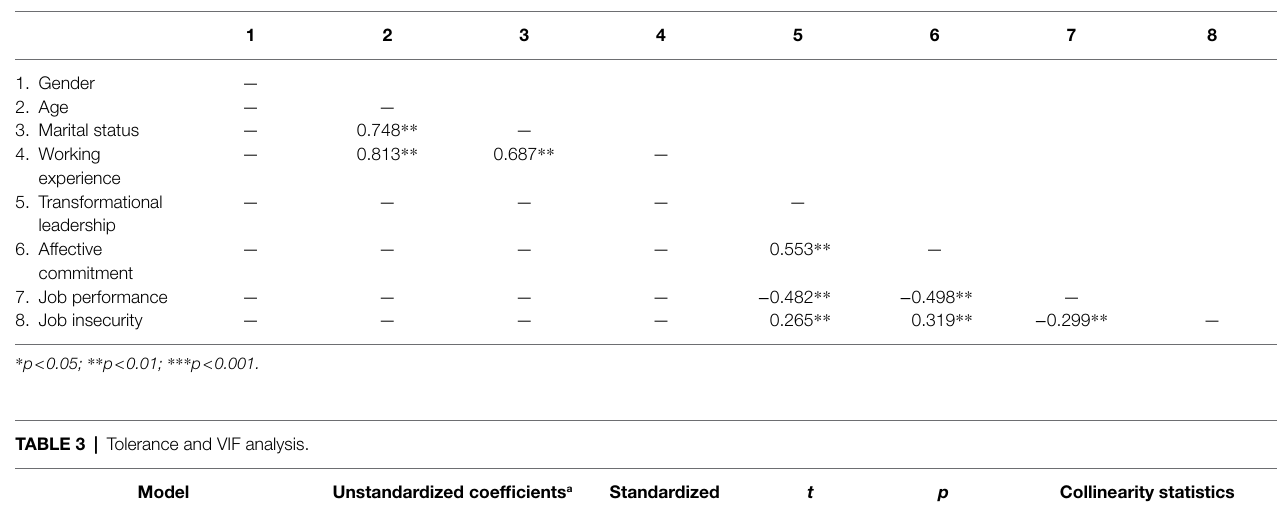
TABLE 2 | Correlation analysis of variables.